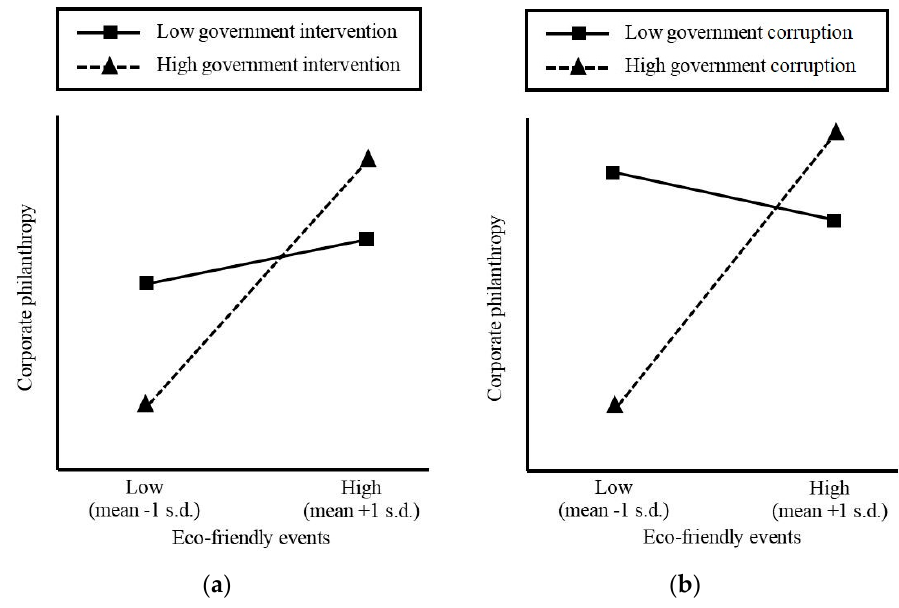
Figure 1. Graphic presentations of moderating effect of government intervention and government corruption in the regression. Specifically: ( a ) the moderating effect of government intervention; ( b ) the moderating effect of government corruption.